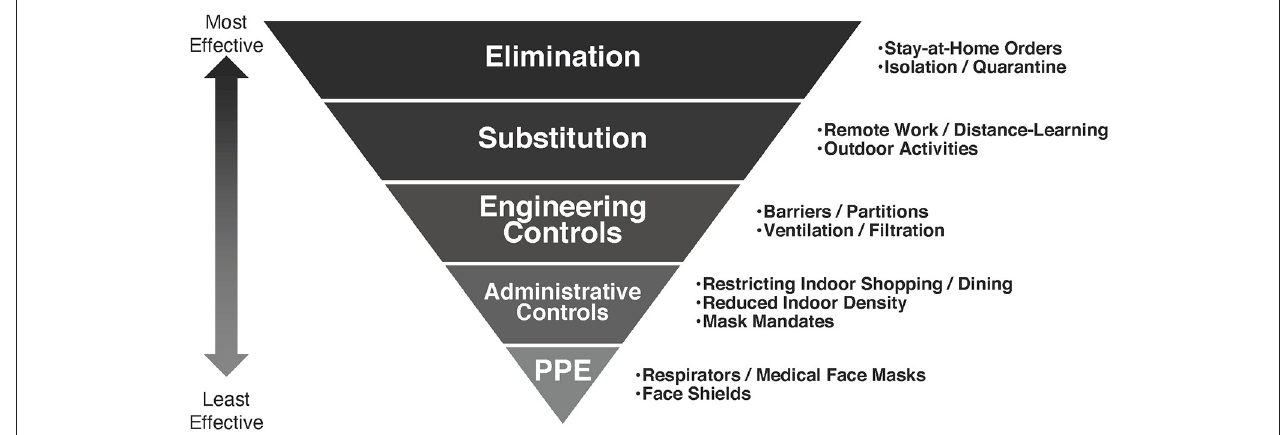
FIGURE 1 | The hierarchy of COVID-19